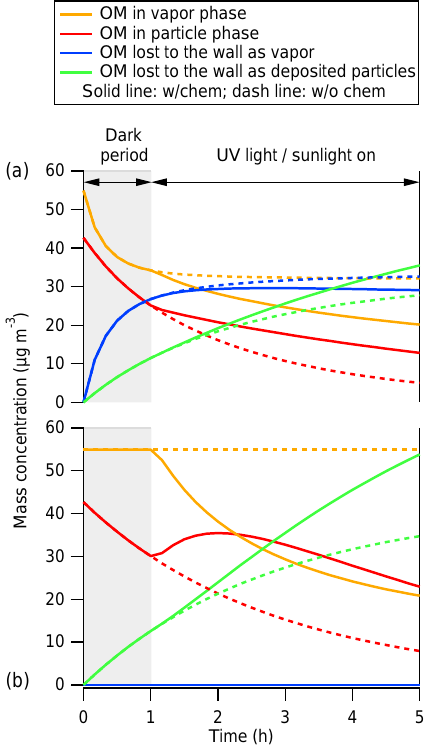
Figure 3. Time evolution of organic mass (OM, in units of µgm − 3 ) in the vapor phase (gold lines) and particulate phase (red lines), averaged over the 18 simulations, assuming no chemical reactions occurring (dashed lines) and including oxidation reactions (solid lines). Simulations with chemistry on use k OH fitted for aromatics with a four-volatility-bin drop in volatility assumed for the prod- ucts. Model (a) with particle and vapor wall loss on and (b) with vapor wall loss off. Particle-phase wall losses are included in both simulations; the masses of particles and vapors lost to the walls have been normalized by the volume of the bag to obtain mass concen- tration units. The simulations use Krechmer’s saturation concentra- tions ( C w / M w γ w ; Krechmer et al., 2016) and a mass accommoda- tion coefficient of 1 × 10 − 5 . In all cases, the first hour simulates the process of primary organic aerosol characterization in the dark (no chemical